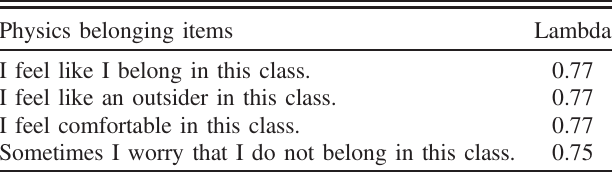
TABLE I. Survey items for students ’ sense of belonging along with factor loadings (Lambda) from the confirmatory factor analysis result for all students ( N ¼ 814 ). The rating scale for the items was not at all true, a little true, somewhat true, mostly true, and completely true. All p values (of the significance test of each item loading) are p < 0 . 001